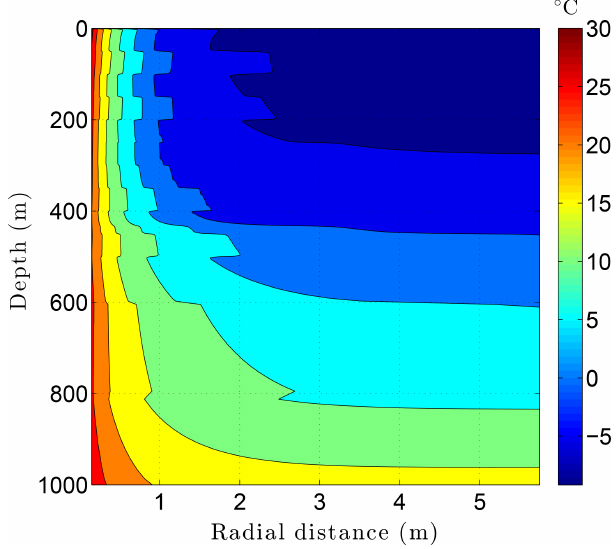
Figure 15. Temperatures in the sedimentary sequence (Fig. 8) pen- etrated by a newly drilled 3km deep borehole (day